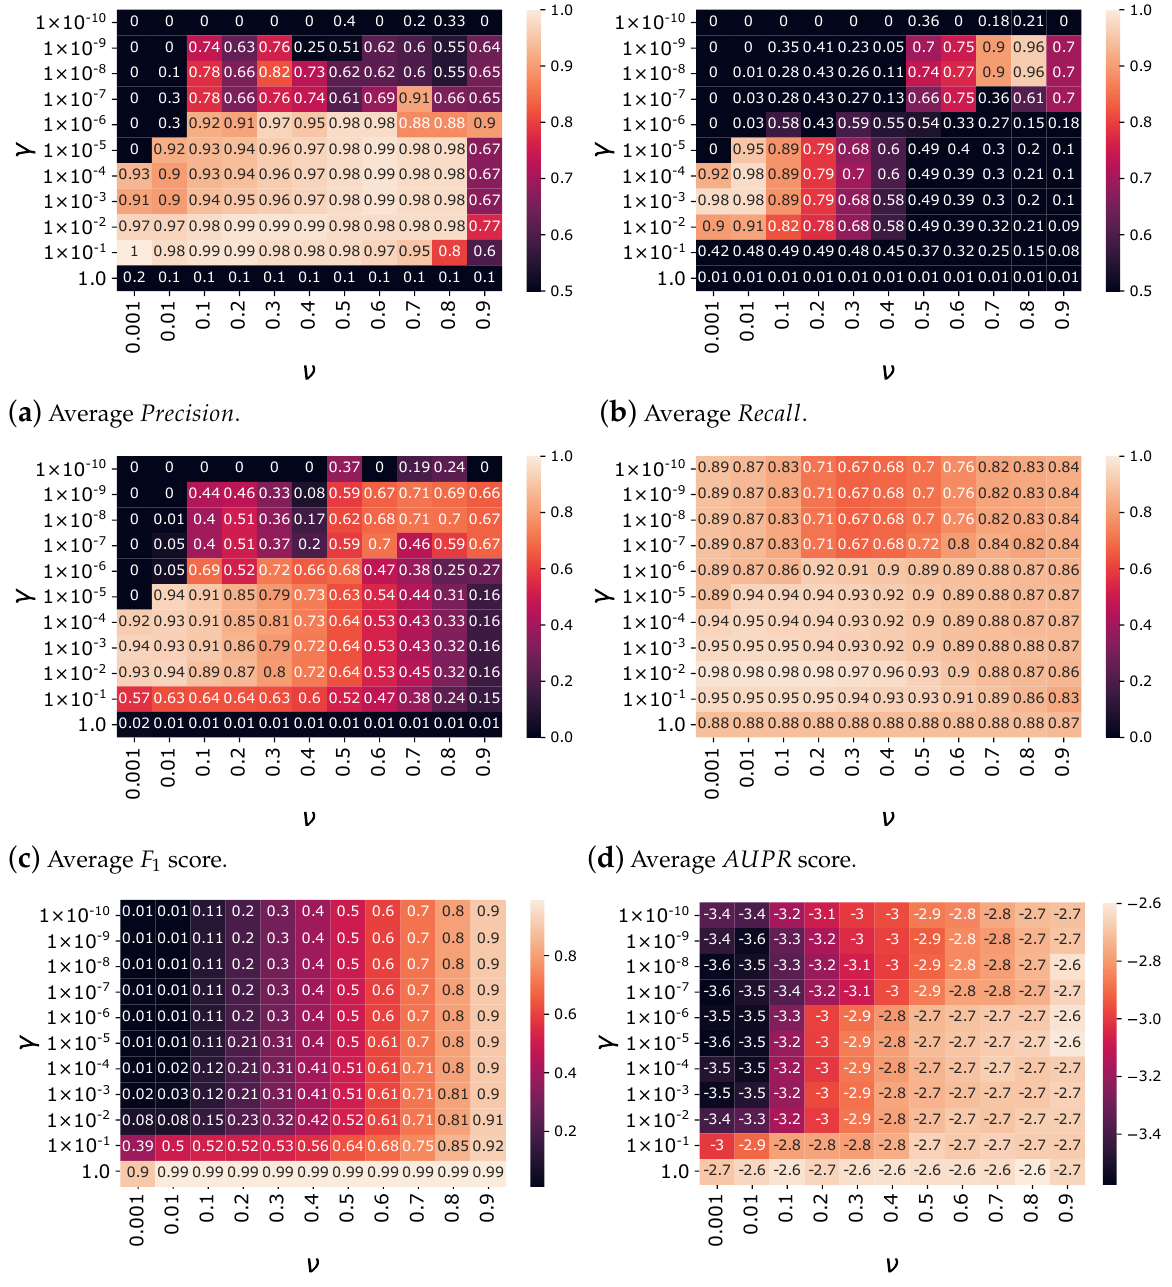
Figure 4. Average Precision , Recall , F 1 , AUPR , relative number of support vectors, and training runtime for 10-fold cross-validation scores over different combinations of parameters γ and ν . Better results are obtained for γ = 10 − 2 and ν = 10 − 2 .